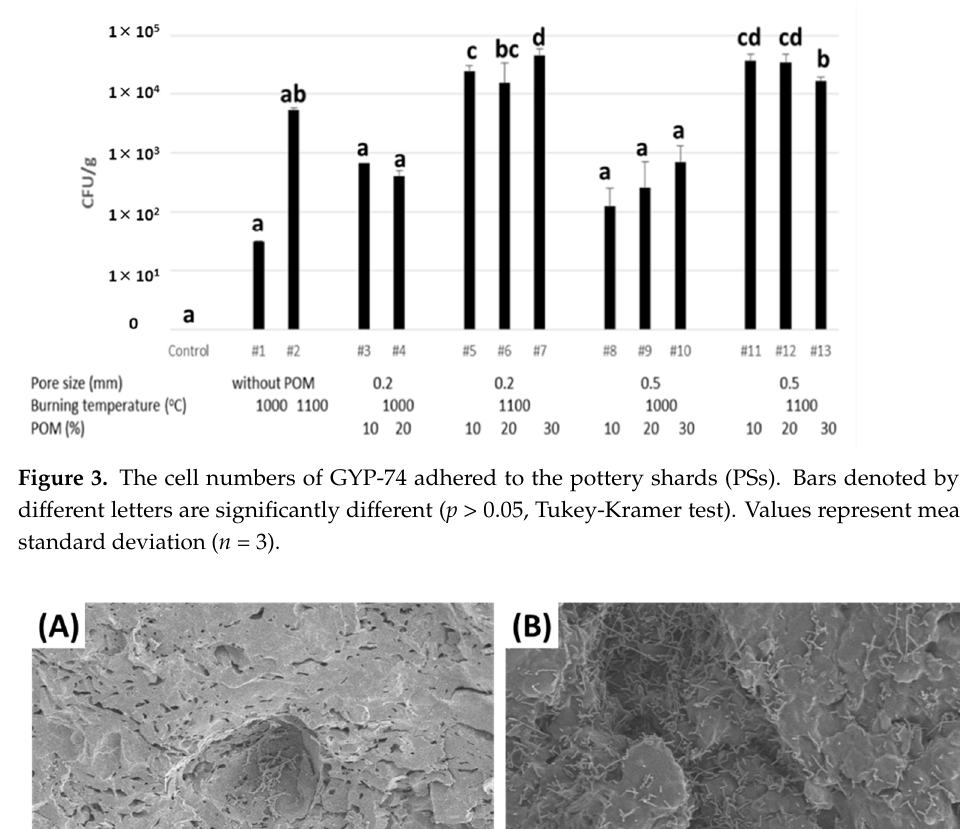
Figure 2. Morphological observation of strain GYP-74 cultured in de Man, Rogosa and Sharpe (MRS) medium with a scanning electron microscope (scale bar, 5 µm).